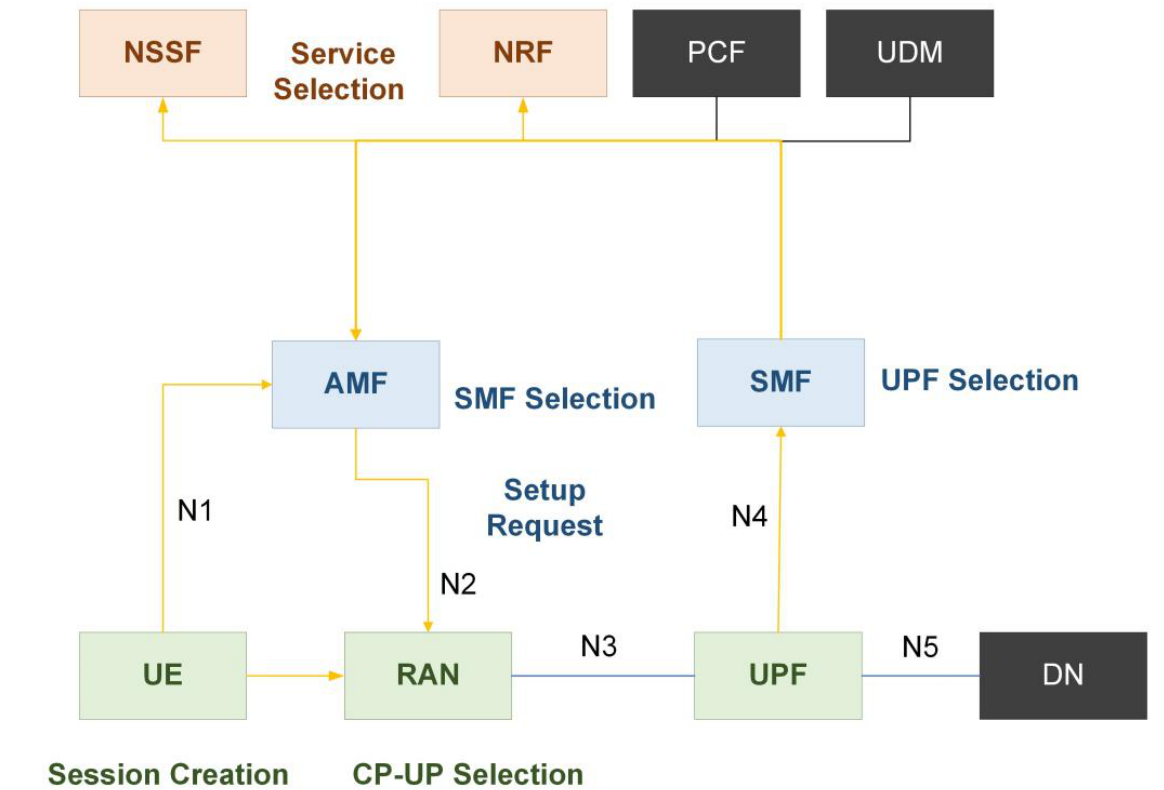
Figure 7. Registration logic of 5G SBA.